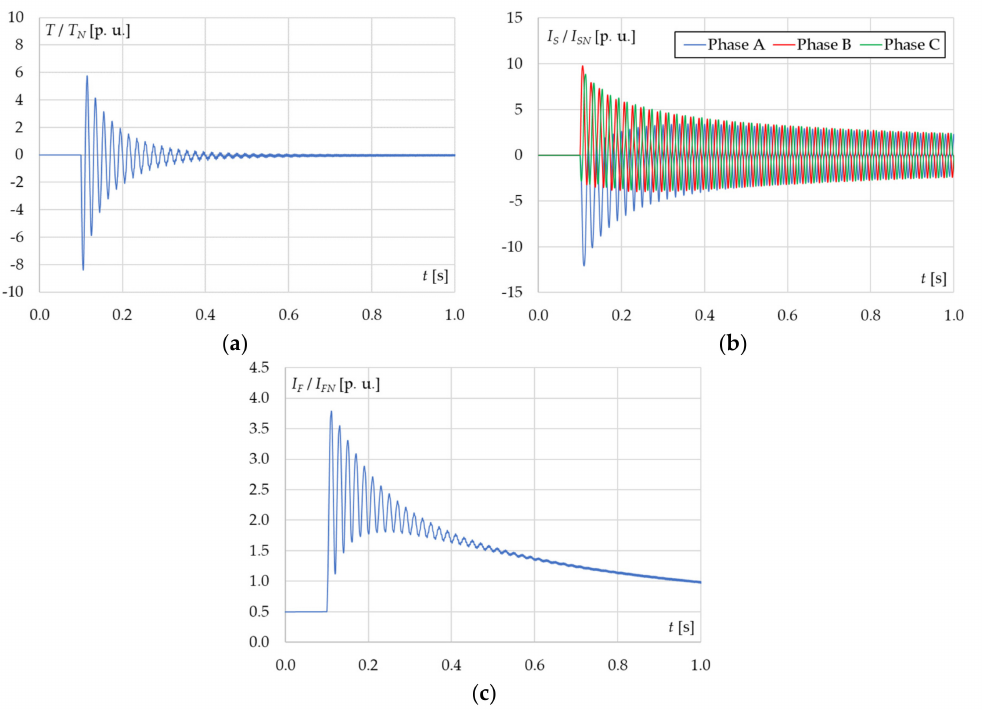
Figure 25. Waveforms of electromagnetic torque ( a ), stator current ( b ), and field current ( c ) during the first second of sudden short